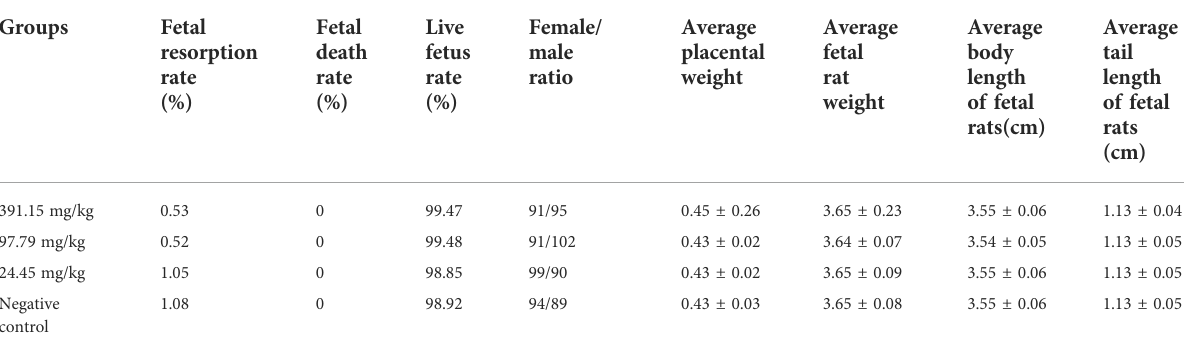
TABLE 11 Effect of MCE on fetal